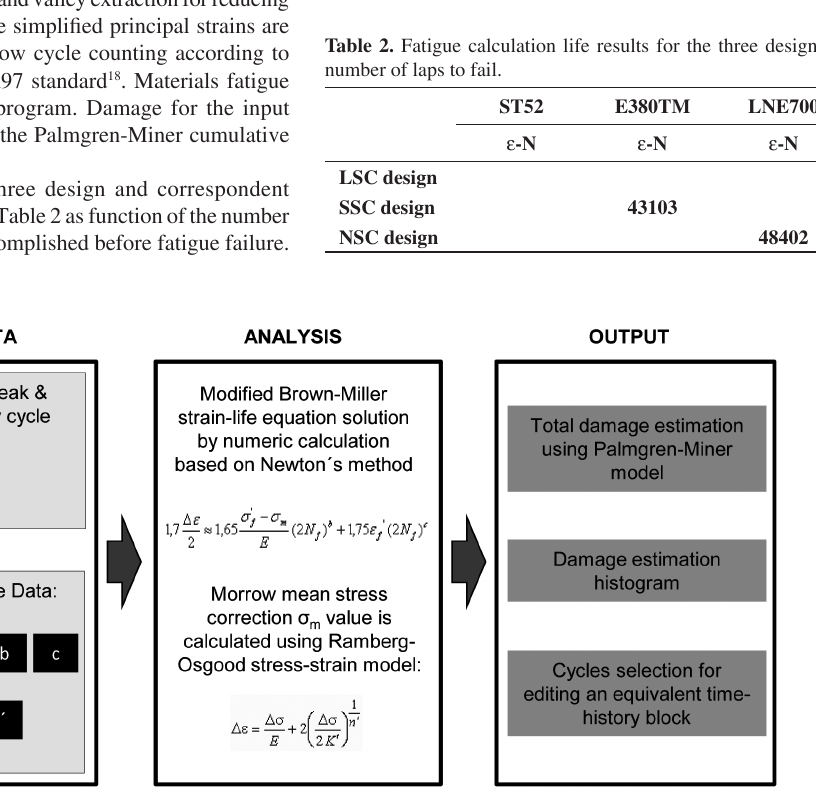
Figure 6. Program algorithm for VBA implementation.